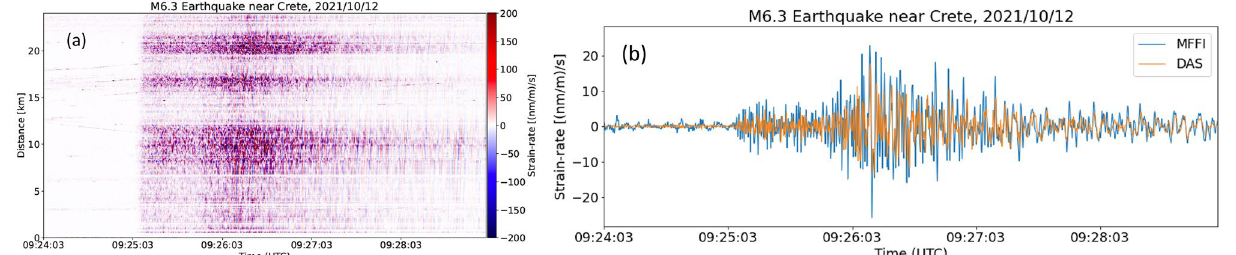
Figure 4. MFFI comparison to DAS interrogator. ( a ) DAS records corresponding to the earthquake taking place east of Crete island [October 12, 2021, 09:24:03 UTC, Crete (ML = 6.3)], ( b ) MFFI strain rate vs. average DAS strain over spatial dimension. The agreement in the estimation of strain rate between the two systems is